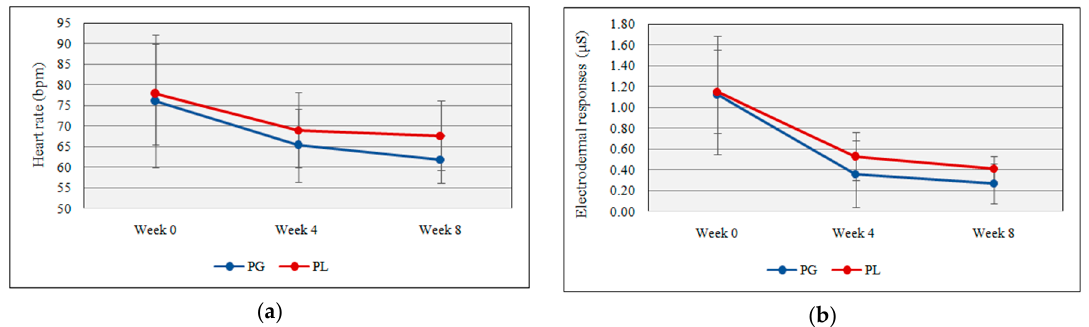
Figure 2. ( a ) Heart rate response deviation throughout the study; ( b ) electrodermal response deviation throughout the study (PG = Probiotic Group, PL = Placebo Group).